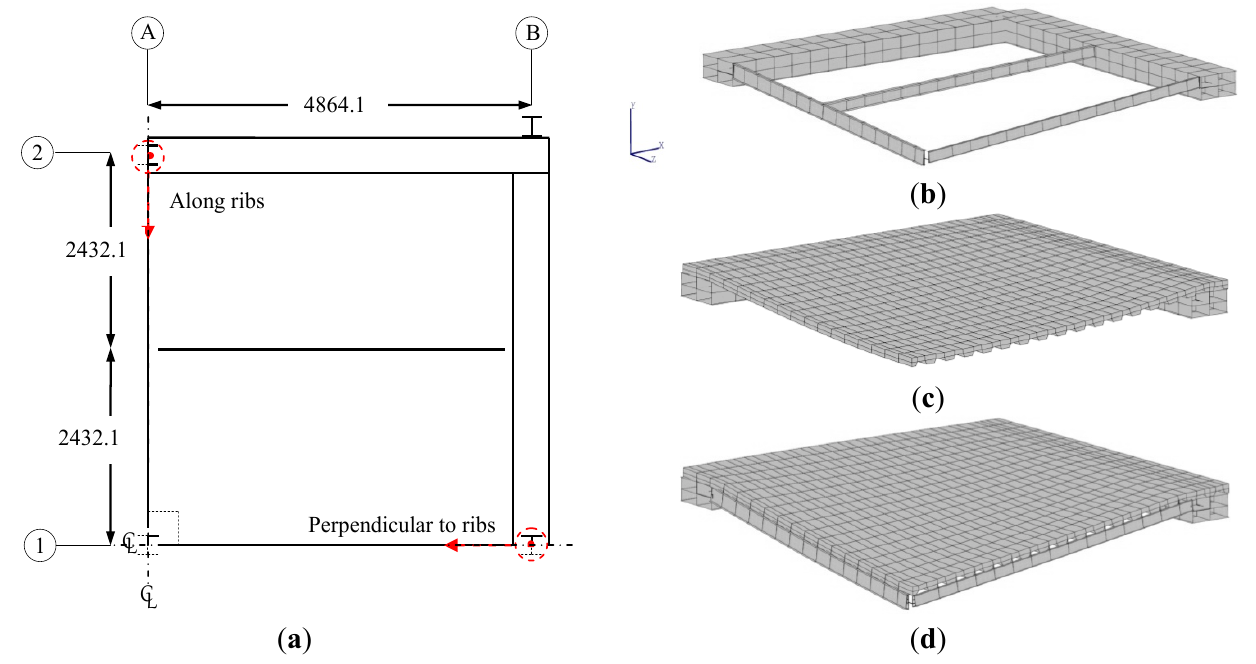
Figure 13. Quarter model for test specimen (all dimensions in mm). ( a ) Test specimen floor plan; (b) Bare steel frame model; ( c ) Composite slab model; ( d ) Beam-slab floor